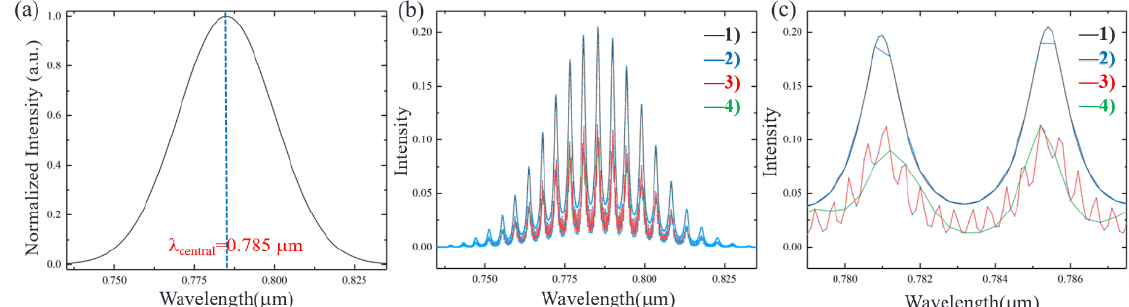
Figure 2. ( a ) Gaussian incident light with a center wavelength of 785 nm. ( b ) The output of Drop (1) without F-P cavity effect ( ∆ λ = 0.1 nm); (2) without F-P cavity effect ( ∆ λ = 0.4 nm); (3) with F-P cavity effect ( ∆ λ = 0.1 nm); (4) with F-P cavity effect ( ∆ λ = 0.4 nm). ( c ) Partial enlarged view in the wavelength range of 779 nm–787.5 nm.